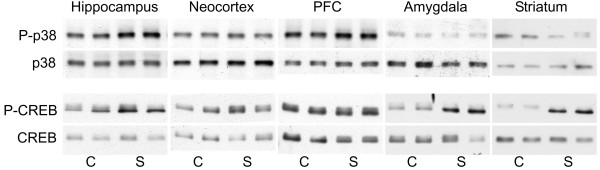
Swim stress generally did not alter p38MAPK phosphorylation but elevated P-CREB in some brain regions. Representative blots are shown. Abbreviations as in the legend to Fig. 1.